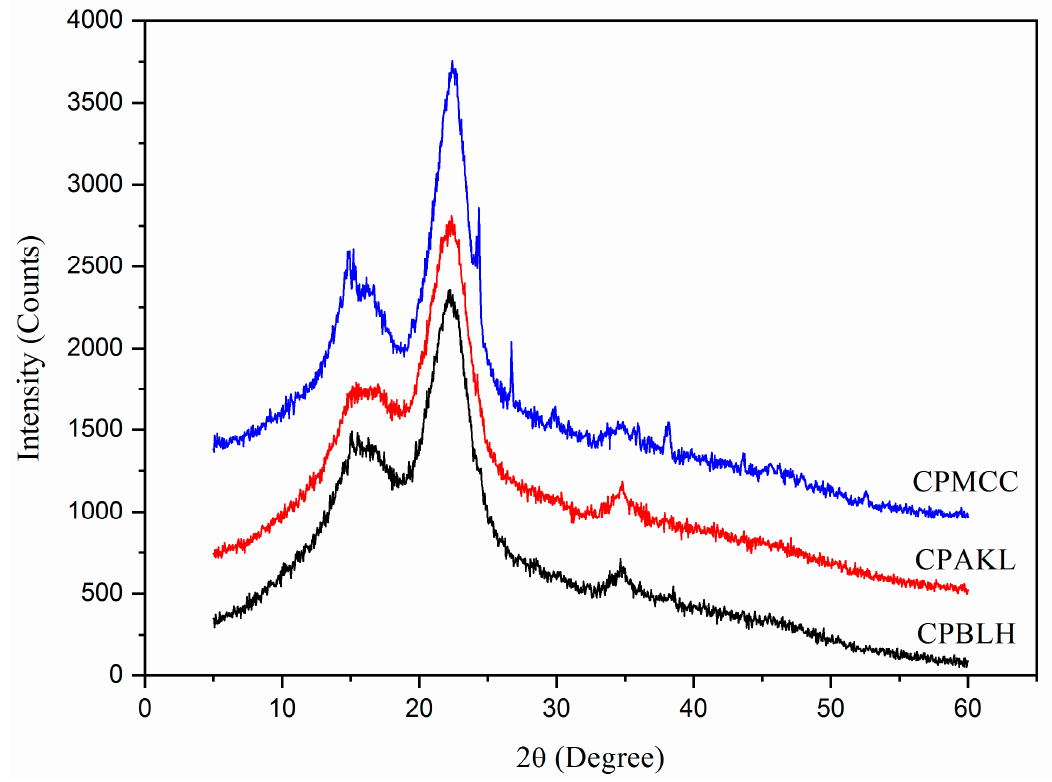
Figure 4. XRD curves of CPBLH, CPAKL, and CPMCC samples.